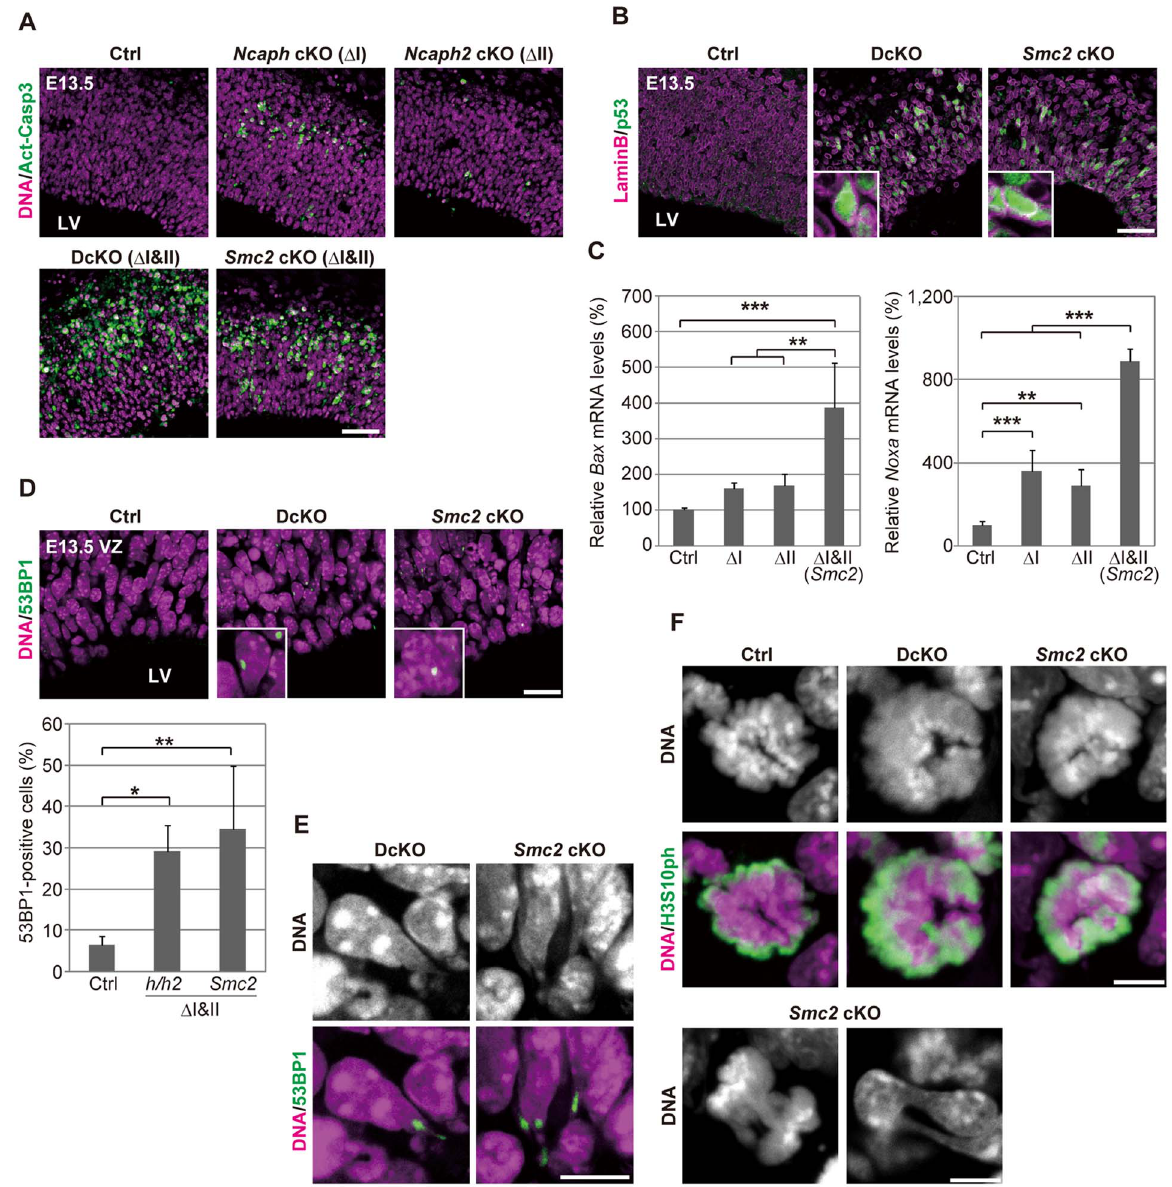
Figure 3. Defective chromosome segregation leads to DNA damage-induced apoptosis in NSCs depleted of both condensins. ( A ) Frozen sections of embryonic brains at E13.5 were immunolabeled with an antibody against an active form of caspase 3 (Act-Casp3), an indicator of apoptotic cell death, and counterstained with Hoechst. The data shown are from a single representative experiment out of three repeats. Sections from at least two different embryos of each genotype were analyzed. Bar, 50 m m. ( B ) Frozen sections were immunolabeled with antibodies against lamin B and p53. The insets show close-ups of p53-positive nuclei. The data shown are from a single representative experiment out of three repeats. Sections from at least two different embryos of each genotype were analyzed. Bar, 50 m m. ( C ) Real-time RT-PCR analysis was performed to determine mRNA levels of two p53 target genes ( Bax and Noxa ) in the cortices of cKO mice at E13.5. The mRNA levels were normalized to the internal control ( Gapdh mRNA level). Data were obtained from four experiments and show the mean mRNA levels of Ctrl mice as 100%. Bars indicate the mean and SD. ** P , 0.01, *** P , 0.001 ( t -test with a Holm correction for multiple comparisons). ( D ) Frozen sections were immunolabeled with a 53BP1 antibody to visualized damaged DNA foci in interphase nuclei. The insets show close-ups of 53BP1-positive nuclei. The panels shown are from a single representative experiment out of three repeats. Sections from at least two different embryos of each genotype were analyzed. Bar, 20 m m. The percentages of 53BP1-positive nuclei in the VZ were measured in the dorsal area of cortices, and plotted in the bottom. Data were obtained from four independent sections from two different embryos. The bars indicate the mean and SD. * P , 0.05, ** P , 0.01 ( t -test with a Holm correction for multiple comparisons). ( E ) Shown are close-up images of cells with tail-like structures from the same experiments as ( D ). Bar, 10 m m. ( F ) Mitotic cells were identified as H3S10ph-positive cells on the apical surface of the VZ (middle panels), and their chromosome morphology was visualized with Hoechst stain (upper panels). Also shown are chromatin bridges in anaphase or postmitotic cells (lower panels) in the same region. The data shown are from a single representative experiment out of three repeats. Sections from at least two different embryos of each genotype were analyzed. Maximum intensity projections are shown. Bars, 5 m m.